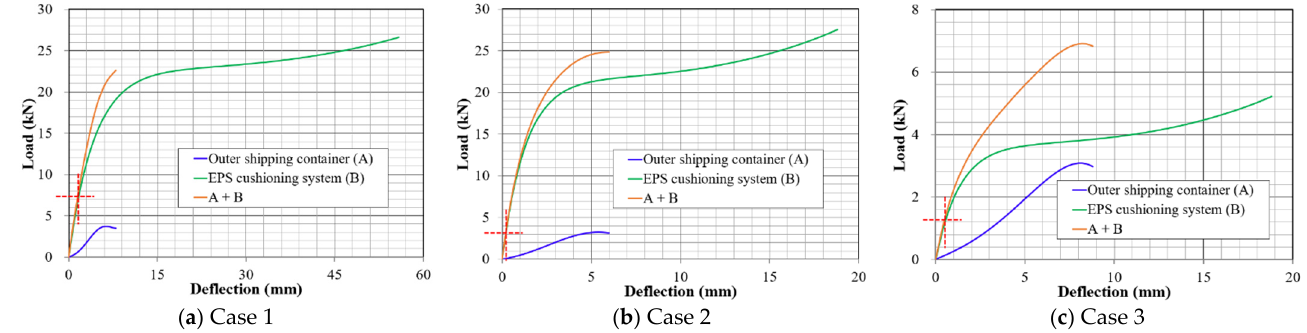
Figure 8. Calculation of load-sharing rate from SS curves of the shipping container and EPS cushioning material.